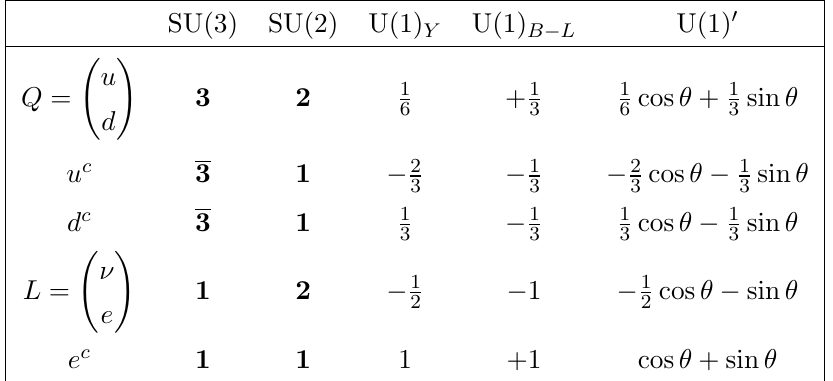
Table 1 . Charges of the SM fermions content under U(1) 0 (cid:17) (cos (cid:18) U(1) Y + sin (cid:18) U(1) B (cid:0) L ) in two component spinor